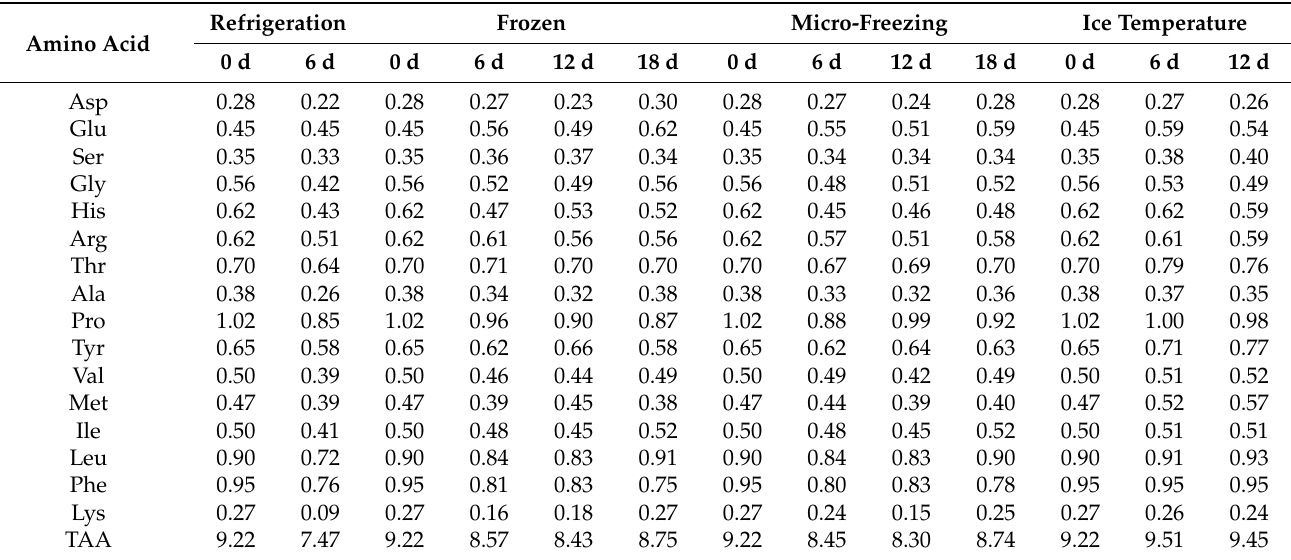
Table 2. Changes of the free amino acid content in beef storage with different low-temperature storage methods (g/100